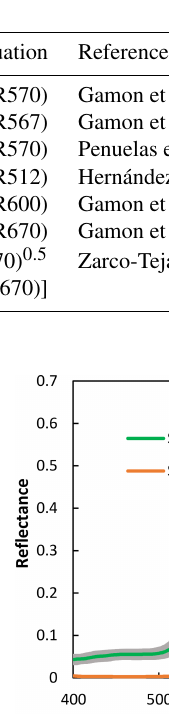
Table 1. Seven PRI formulations used in this study. R is the reflectance at the specified wavelength in nanometers. RDVI is the renormalized difference vegetation index.